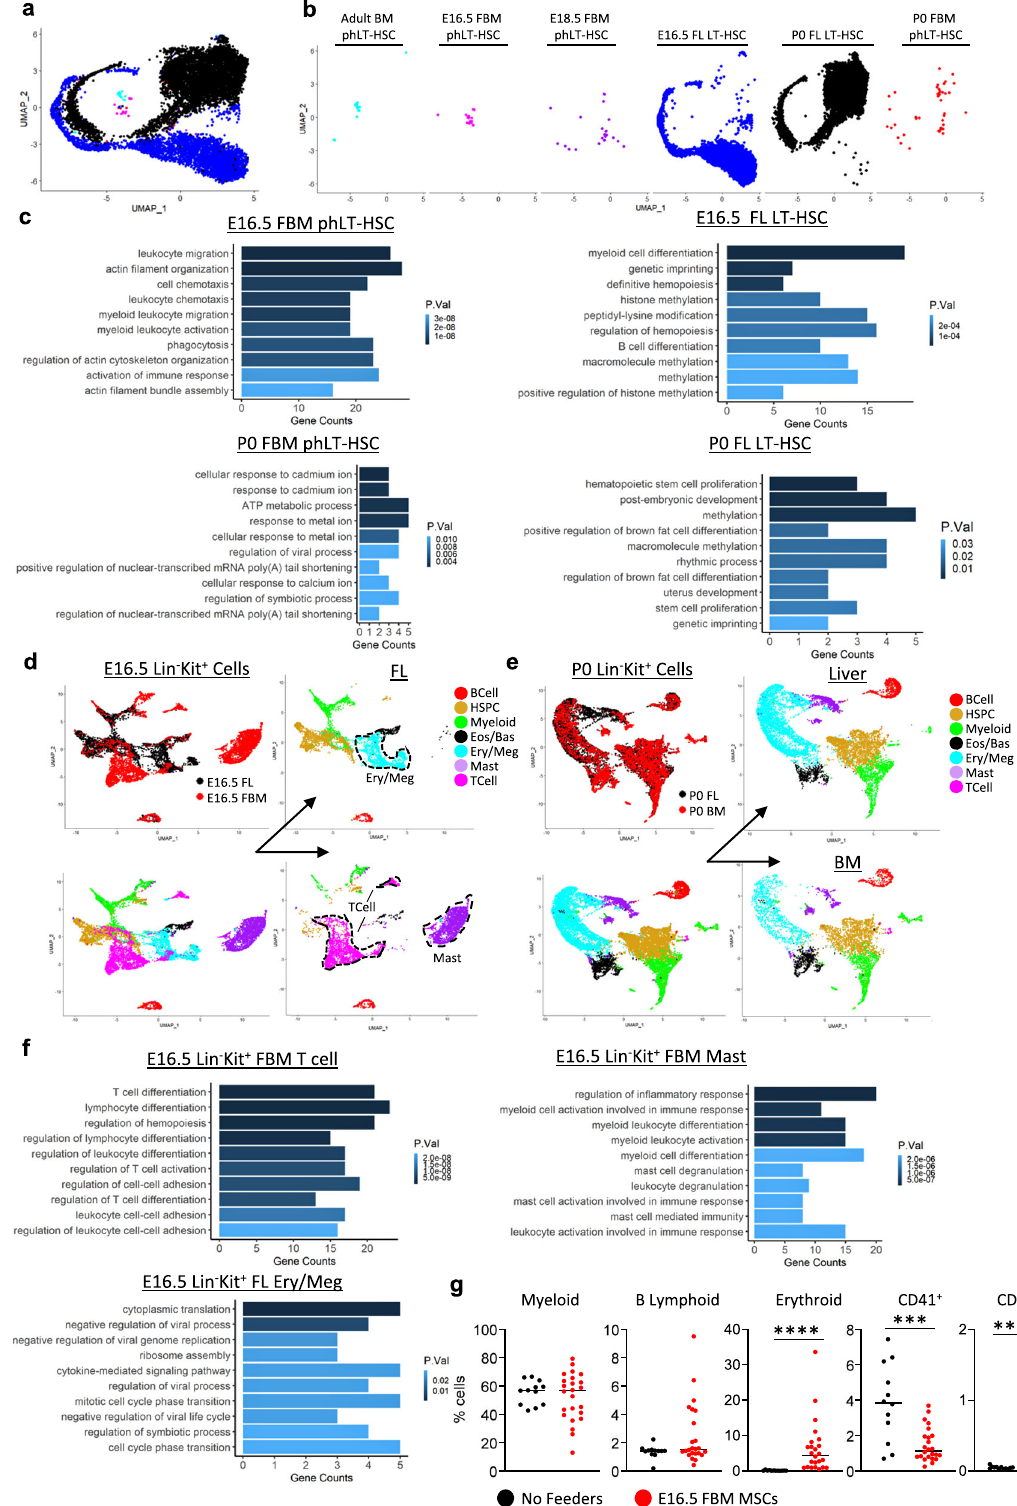
Fig. 6 | FL and FBM HP and HSPCs are transcriptionally distinct. a , b Merge of FBM phLT-HSCs across development with E16.5 and P0 FL LT-HSCs. c GO terms for FBM phLT-HSCs and FL LT-HSCs at E16.5 and P0. d Merge of E16.5 Lin - Kit + cells from FBM and FL. e Merge of P0 Lin - Kit + cells from BM and liver. f GO terms for E16.5 FBM T cells (left), E16.5 FBM Mast cells (middle), and E16.5 FL Ery/Meg cells (right). g Differentiated cell output of E16.5 FL LT-HSCs cultured with or without E16.5 BM MSCs.*** P =0.0008;**** P <0.0001. c , f P valuesdeterminedbyBonferronicorrection.